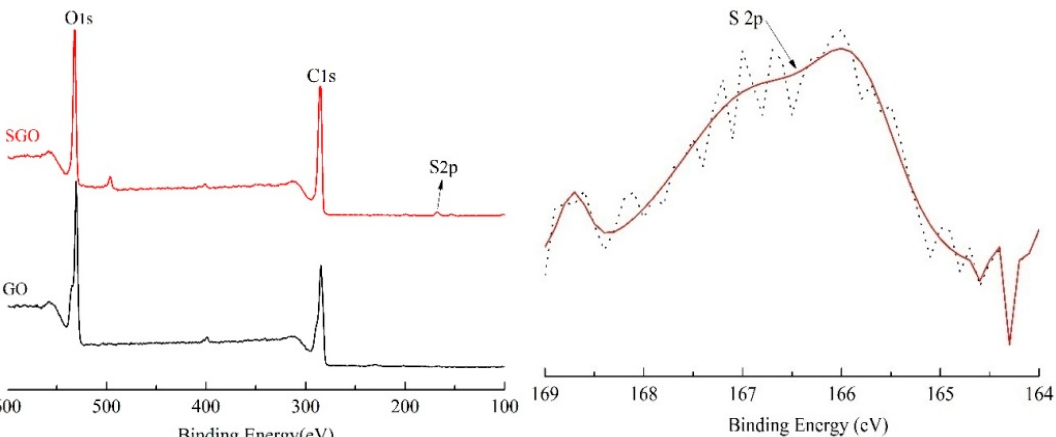
Figure 4. XPS spectra of SGO.